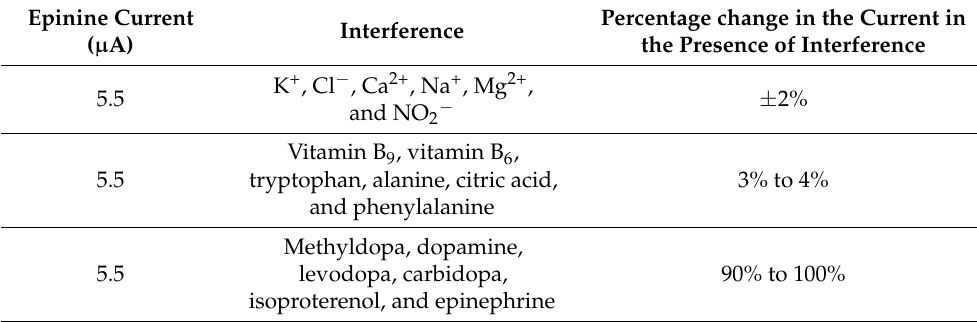
Table 1. Study of the effects of some interferences in the determination of 50.0 µ M epinine (n = 5). Each measurement was conducted with a new electrode surface.